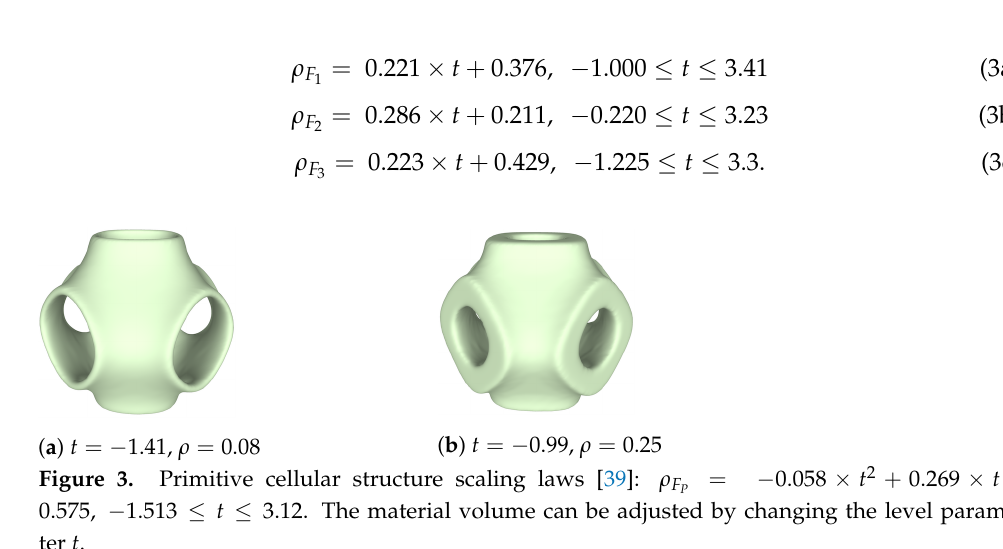
Figure 3. Primitive cellular structure scaling laws [39]: ρ F 0.575, − 1.513 ≤ t ≤ 3.12. The material volume can be adjusted by changing the level parame- ter t